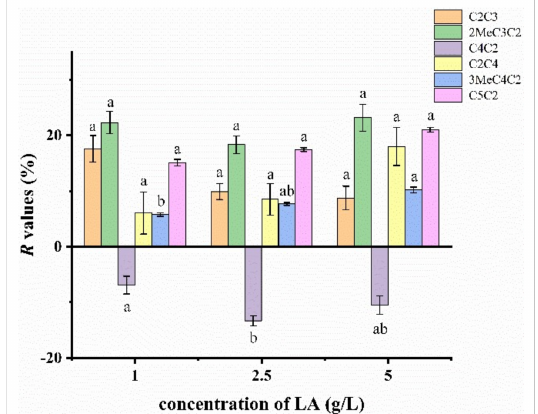
Figure 6. R values of esters in 1, 2.5 and 5 g/L of LA solution. Different letters indicate significant difference for each ester ( p <